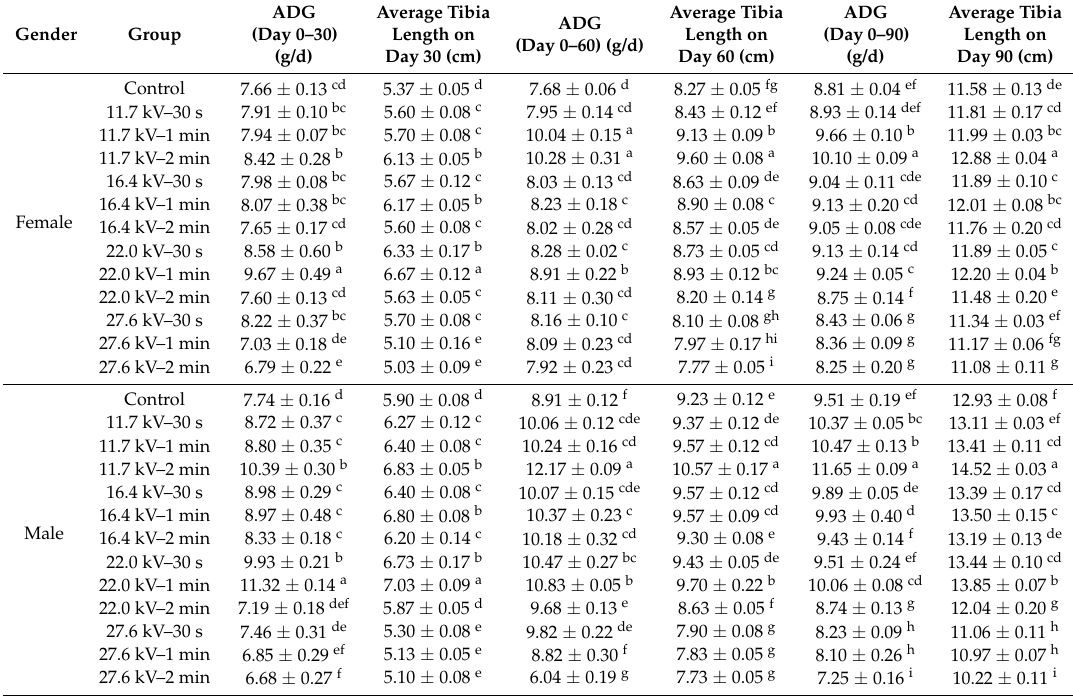
Table 1. Effect of plasma exposure at different potential and duration on the average daily gain (ADG) and tibia length of chickens.